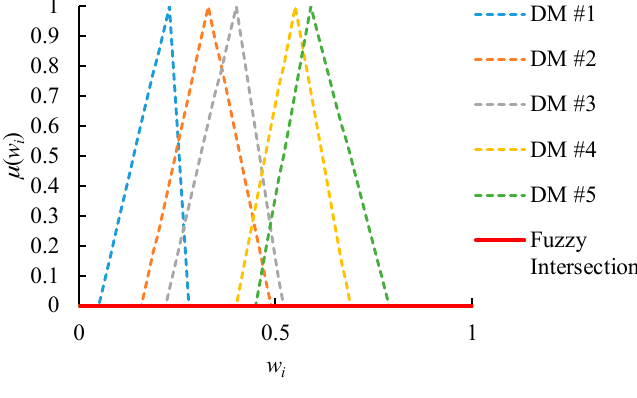
Figure 3. An Figure 3. An example.